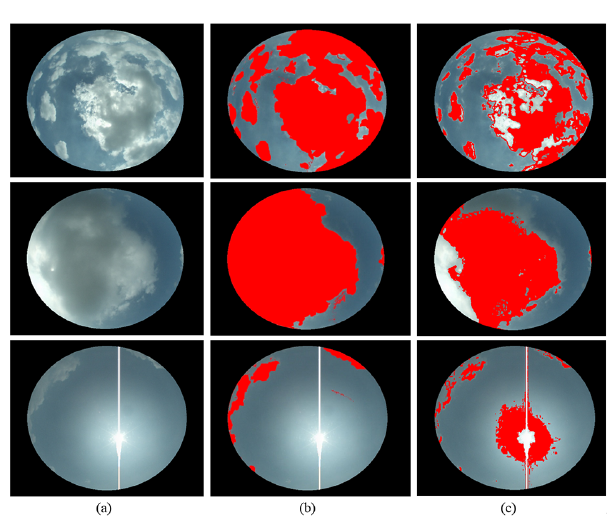
Figure 9. Selected results: (a) original images; (b) detection results of the proposed method; (c) detection results of RBR 0.8–0.9.